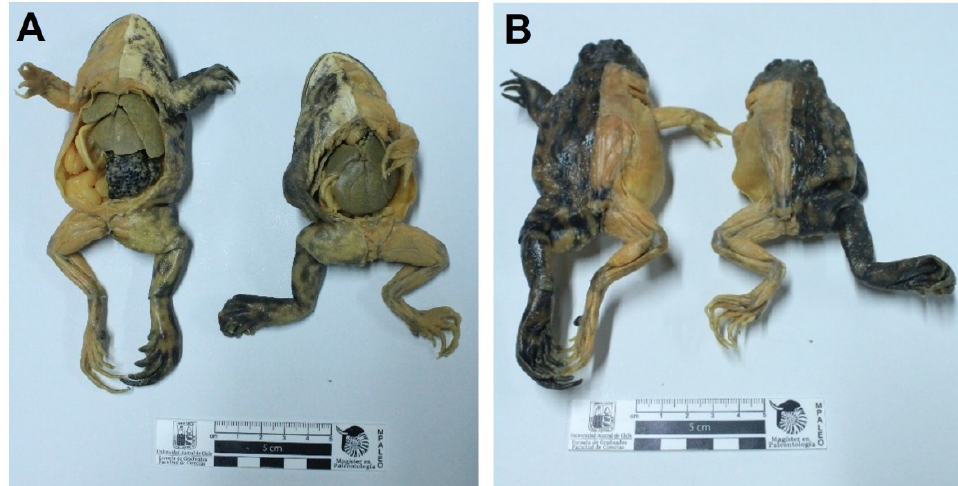
Figure 4. Photograph of two specimens of Chilean frog ( Caudiverbera gayi ), ventral ( A ) and dorsal ( B ) view, preserved by the modified Elnady technique. These specimens were not pigmented. Notice that the musculature and organs are pale and unnatural.